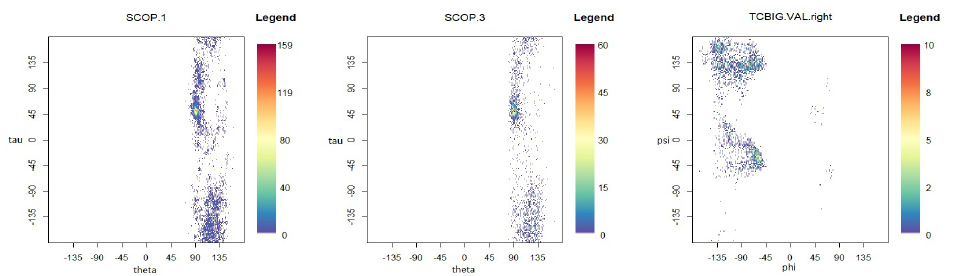
Figure 8. Ramachandran plots for each